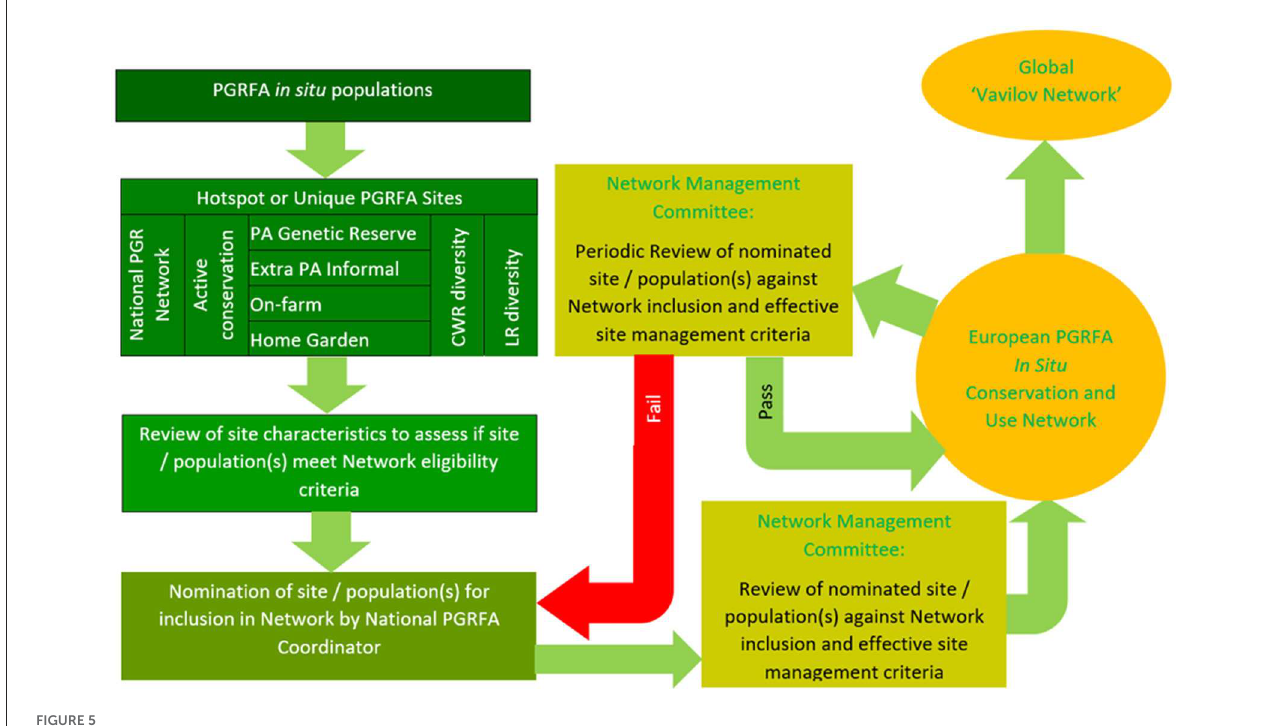
FIGURE5 Methodology for CWR site/population to join the network (Maxted et al., 2015).